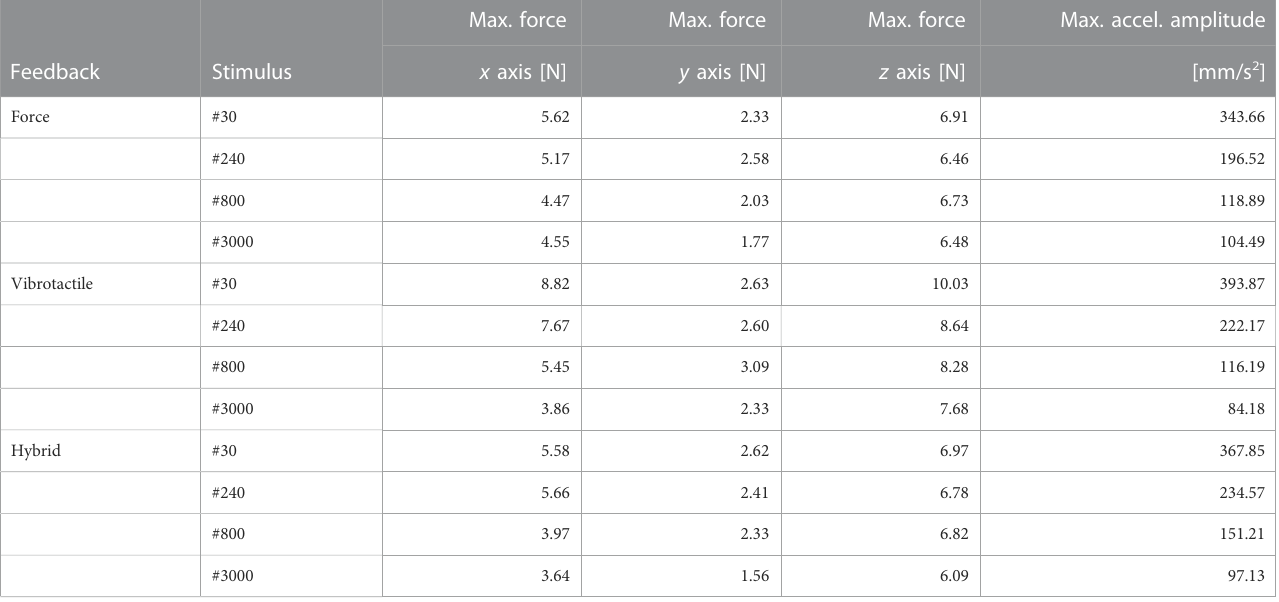
TABLE 2 Mean force and acceleration values during roughness discrimination using stroke touch